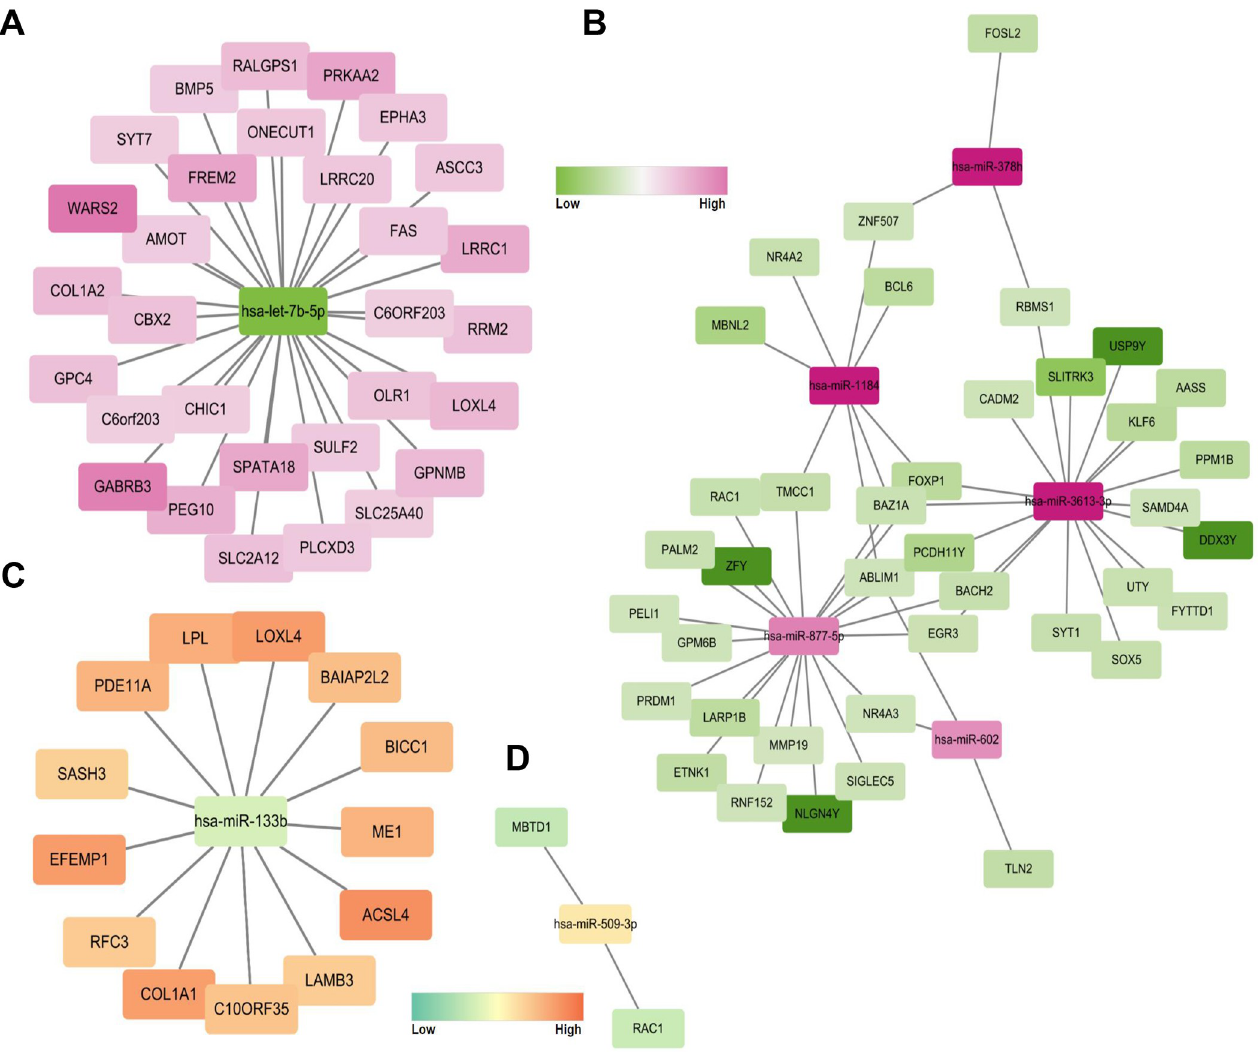
Fig 4. Network analysis of mRNA–miRNA interactions with the GSE89632 dataset. A network between a less expressed miRNA (our data) and a more expressed gene (GSE89632) (A), and between a more expressed miRNA (our data) and a less expressed gene (GSE89632) (B) in people with high fibrosis. The closer to green, the less expressed (that is, more likely to be affected by miRNA), and the closer to pink, the more expressed. A network between a less expressed miRNA (our data) and a more expressed gene (GSE89632) (C), and between a more expressed miRNA (our data) and a less expressed gene (GSE89632) (D) in people with high NAS. The closer to green, the less expressed (that is, more likely to be affected by miRNA), and the closer to orange, the more expressed.